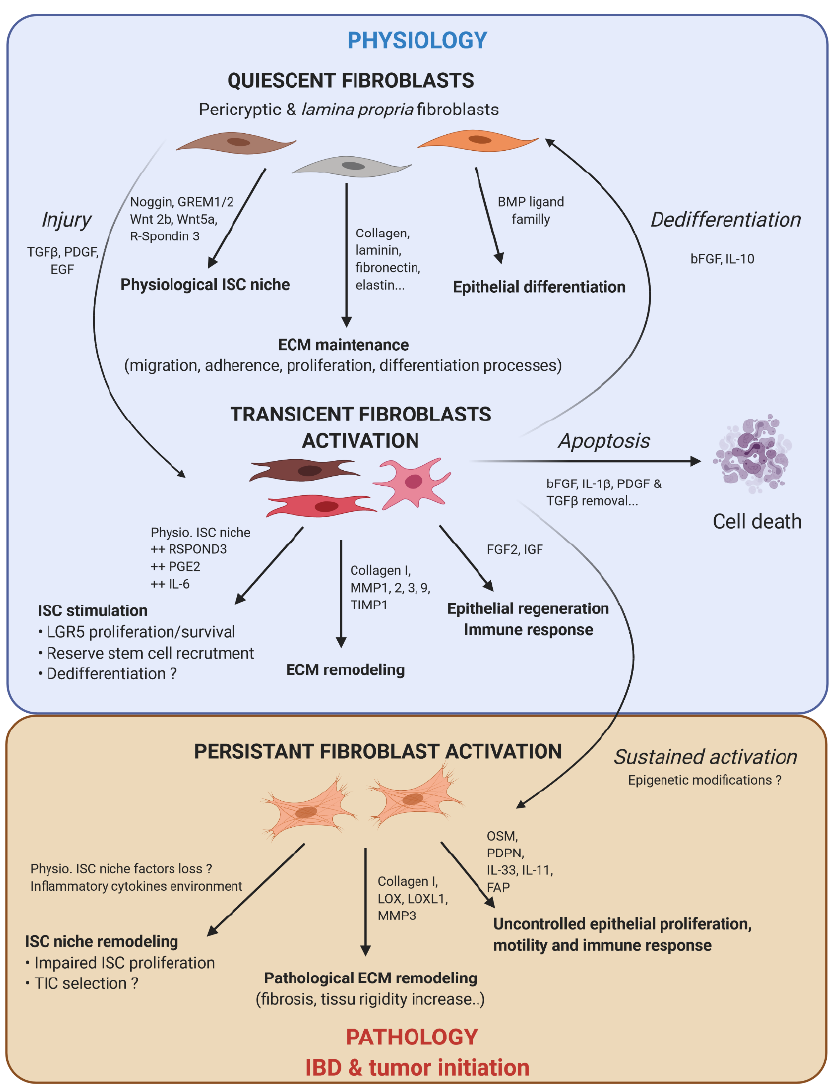
Figure 2. Fibroblast activation dynamic switch depending on the physiopathological context. Normal fibroblasts have a pivotal role under the physiological context to produce ECM protein, control ISC compartment proliferation/differentiation, and maintain intestinal tissue homeostasis. Fibroblasts are very plastic cells able to respond to their environment by becoming activated in case of injury to support ISC proliferation and renewal. To compensate eventual ISC loss, the intestinal epithelium can call on reserve stem cells, which can be recruited by stromal stimulation, in particular prostaglandin E2 (PGE2), or a dedifferentiation of secretory or fully differentiated progenitors, to join the compart- ment strain and thereby regenerate the epithelium. After epithelium repair, the activated fibroblasts can either become quiescent again, or regain their physiological function (by dedifferentiation), or die by apoptosis. However, if the injury persists and becomes chronic, the activated fibroblasts are locked into this state (possibly due to changes in the epigenetic status). This is where activated